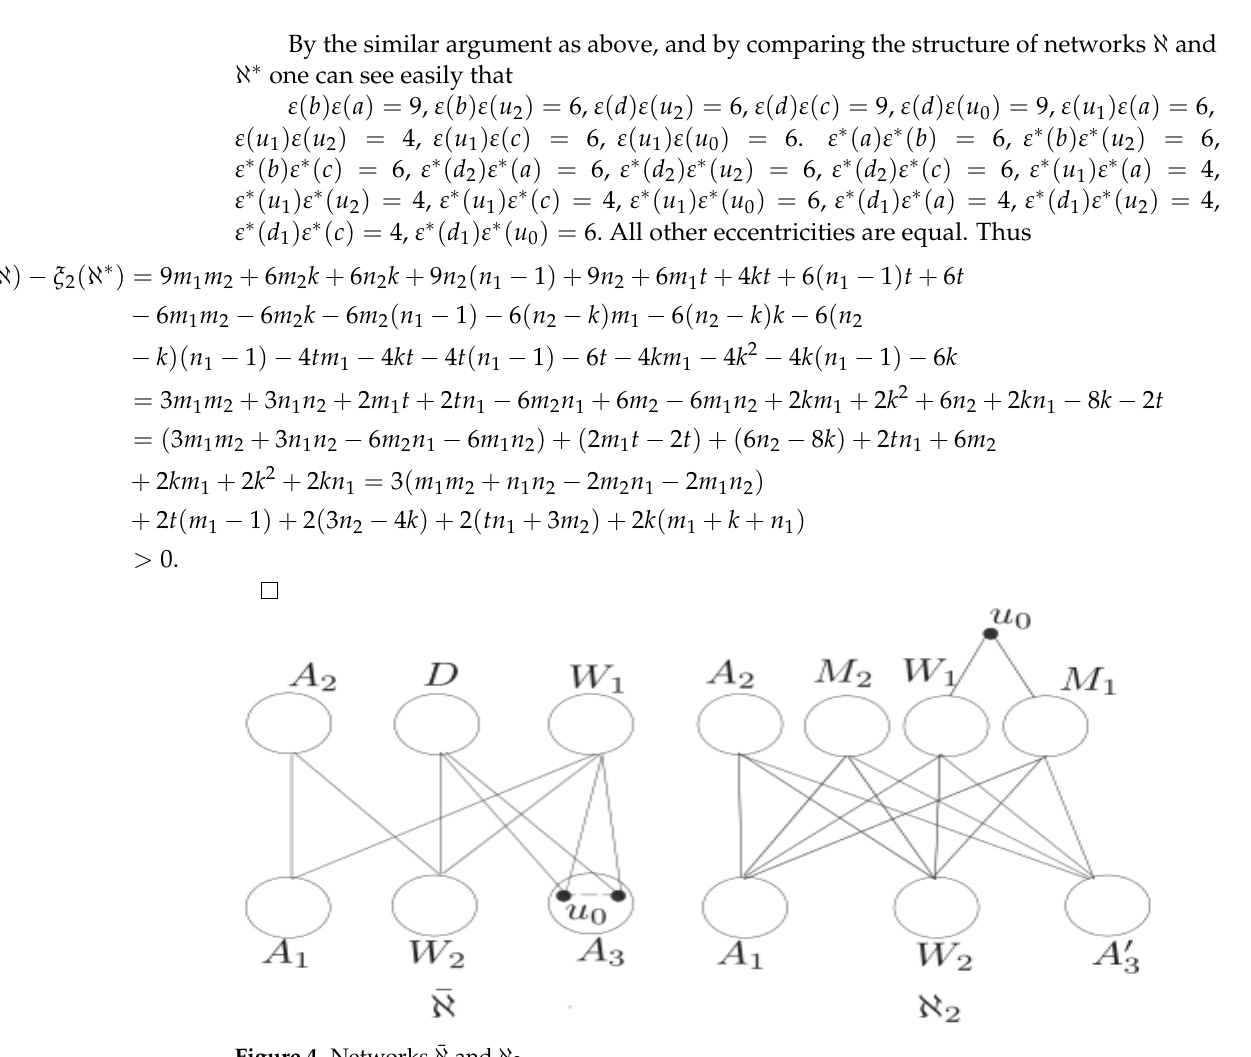
Figure 4. Networks ¯ ℵ and ℵ 2